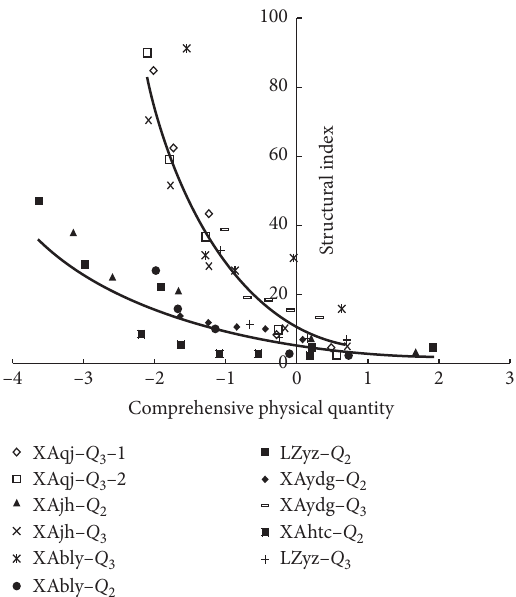
Figure 16: Relationship between the structural index of loess and the comprehensive physical quantity